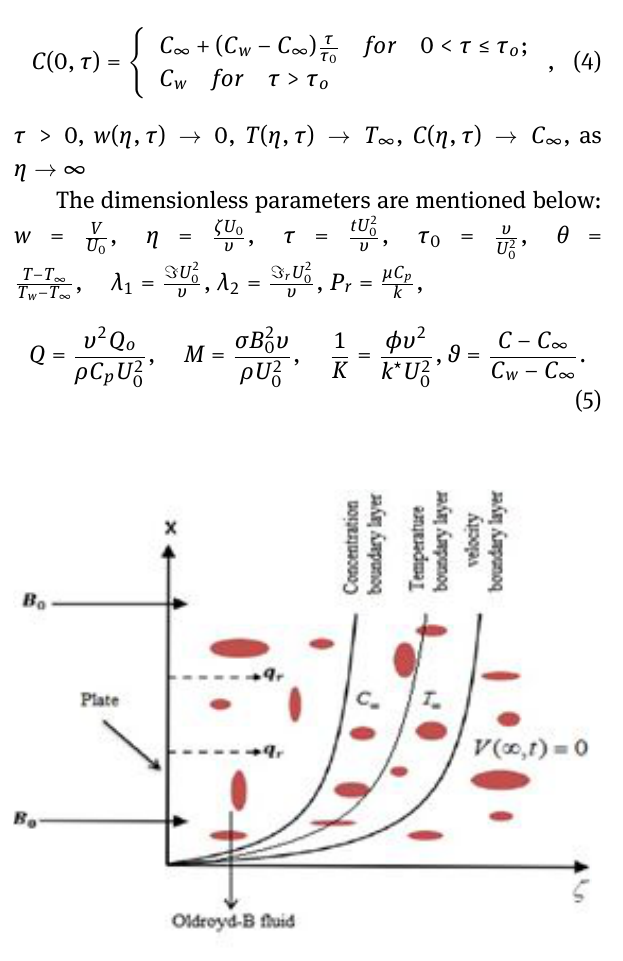
Figure 1: Geometry of Oldroyd-B model